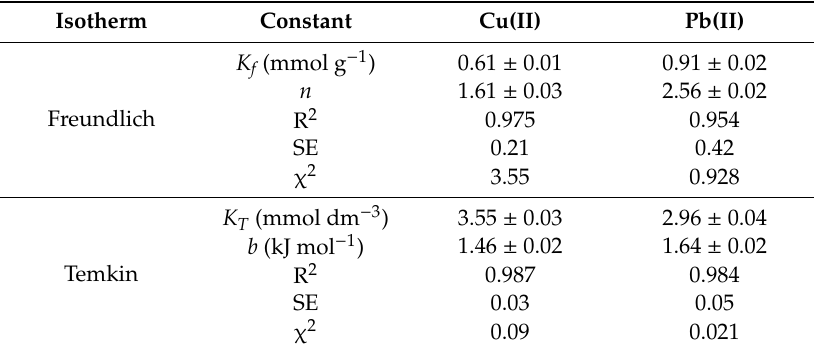
Table 3. Number of moles sorbed ( Nf ), parameters of the Freundlich ( n and Kf ), Temkin ( b and K T ), correlation coe ffi cients ( r ), and respective error for the interaction of divalent metals with chitosan CH-AN at 298 ± 1 K, using a linear method.